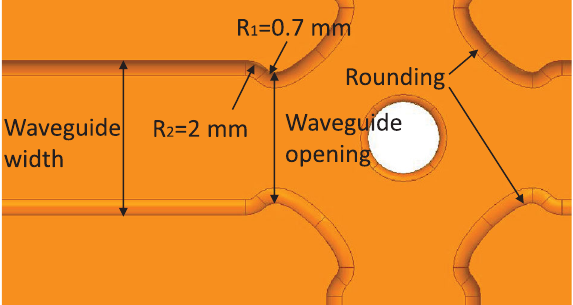
FIG. 10. Machining cost and pulsed surface heating versus rounding.